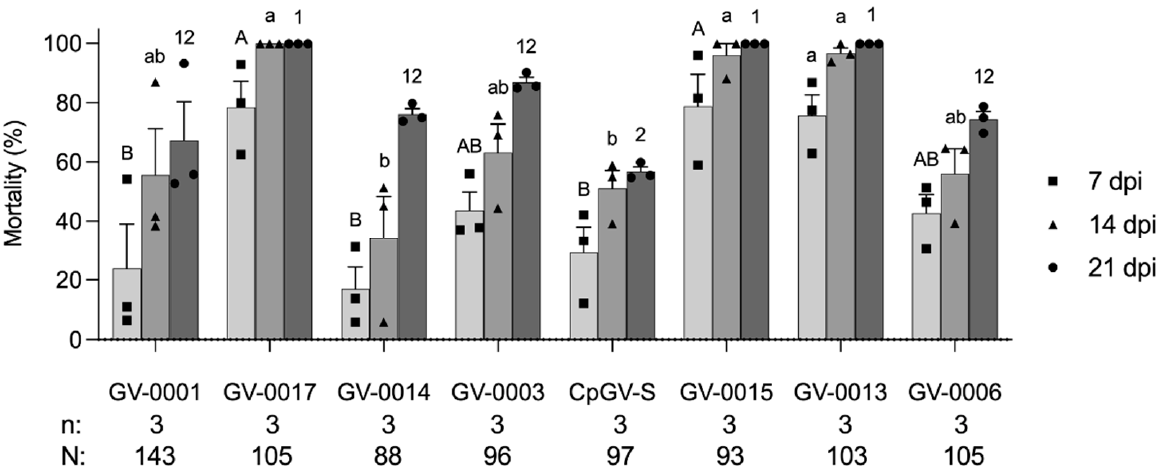
Figure 2. Mortality (mean ± standard error) of first instars of codling moth from WA3 colony exposed to eight CpGV formulations at a concentration of 6 × 10 4 OBs/mL. Mortality was recorded at 7, 14, and 21 days post infection (dpi). Each data point representing the mortality at 7, 14, and 21 dpi was plotted as a square, triangle, and circle, respectively. Data were analyzed with one-way ANOVA followed by Tukey–Kramer HSD comparison at p < 0.05. Different capital letters, lowercase letters, and numbers represent the significant differences of mortality at 7, 14, and 21 dpi, respectively. All tested individuals (N) and replicates (n) are shown below the chart.